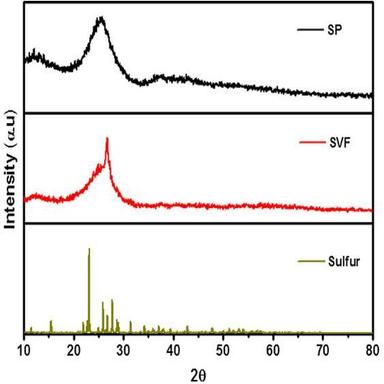
XRD patterns of sulfur, SVF, and SP composites. process .